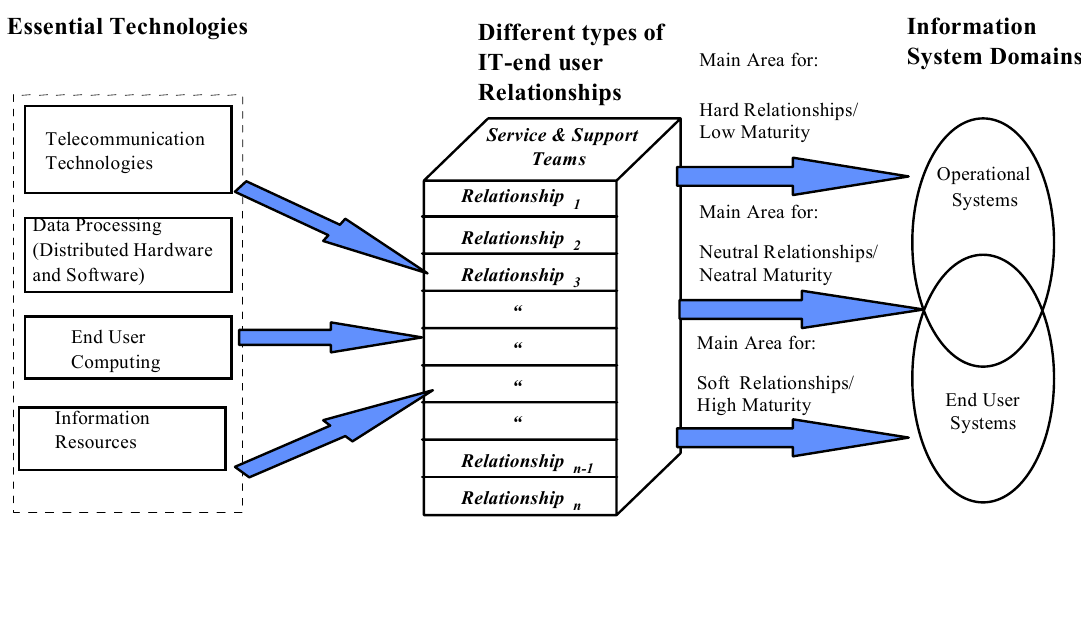
Figure 3: Relationship types and end user maturity levels in an IT-end user relationship environment (based on the work of Sprague & McNurlin (1993), Gunton (1990) and Di Carlo